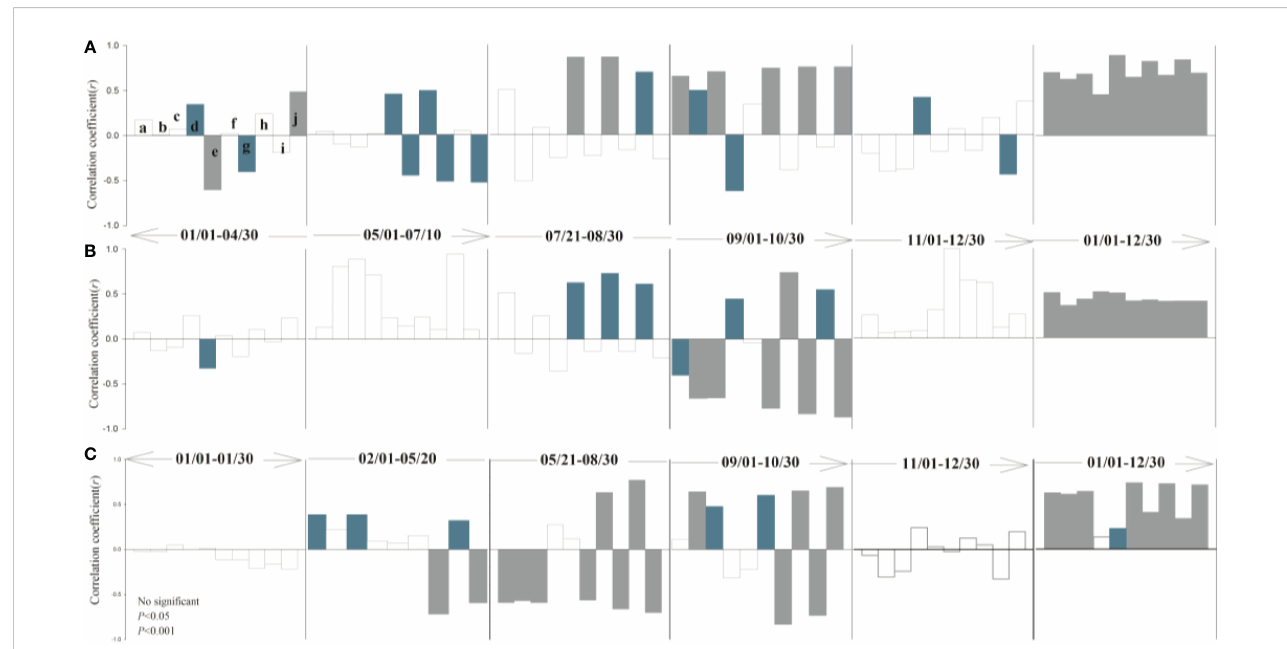
FIGURE 4 Partial correlation analysis between leaf canopy (A) , growth rate (B) , shoot-to-root (C) and climatic factors (a: daily mean air temperature; b: daily minimum air temperature; c: daily maximum air temperature; d: daily precipitation; e: soil moisture -10 cm; f: soil temperature -10 cm; g: soil moisture -20 cm; h: soil temperature -20 cm; I: soil moisture -30 cm; j: soil temperature -30 cm). Correlation coef fi cient >0 denotes positive correlation, while correlation coef fi cient <0 denotes negative